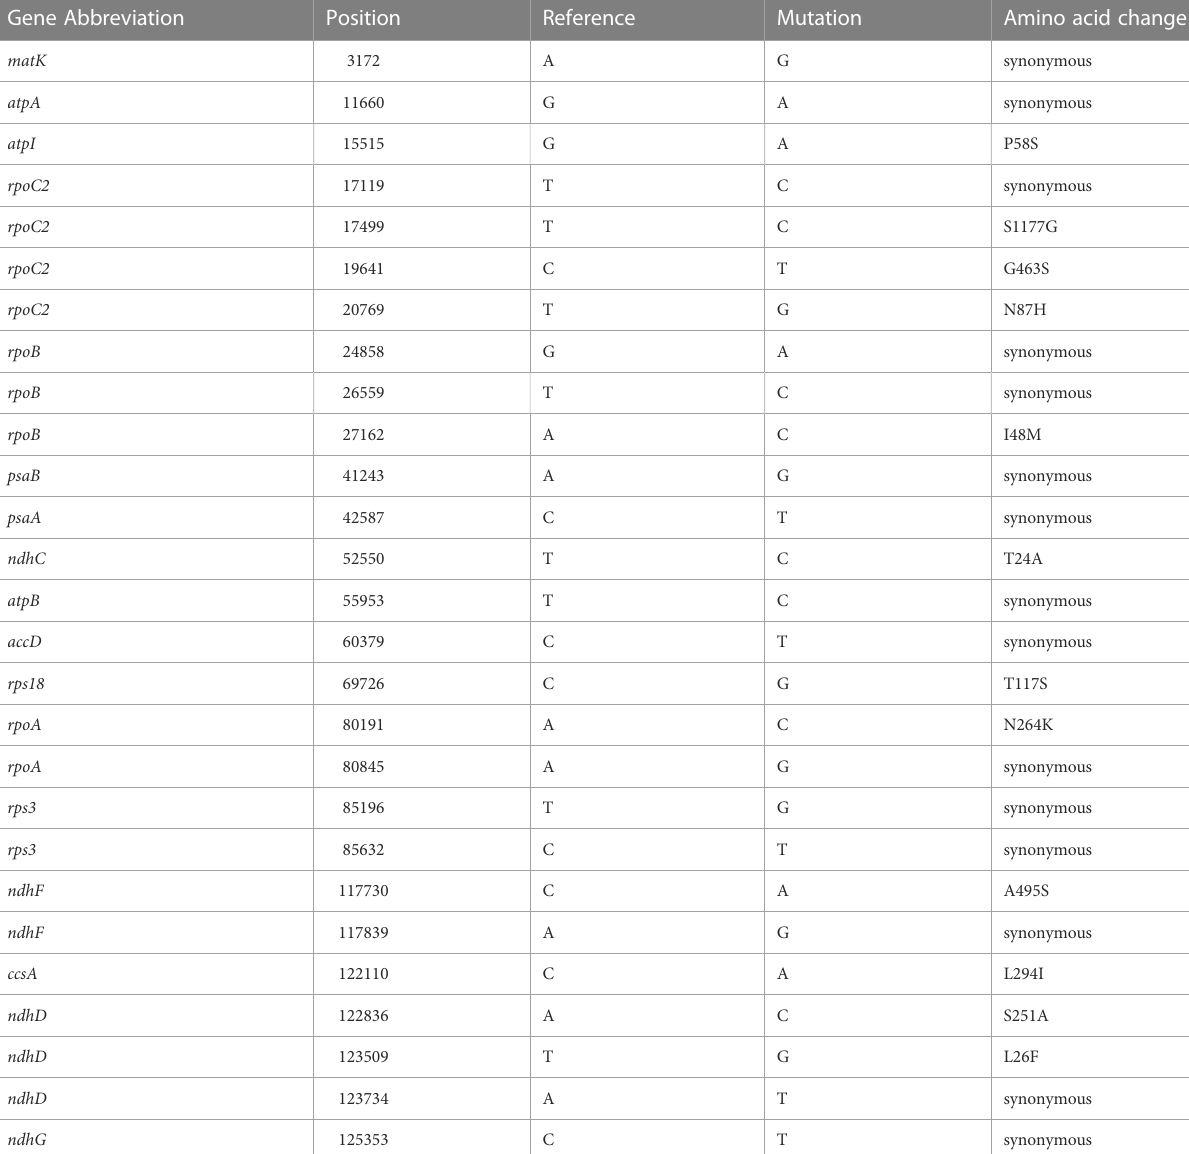
TABLE 3 Variation positions found in the marama chloroplast coding sequence and their effect on the resulting amino acid